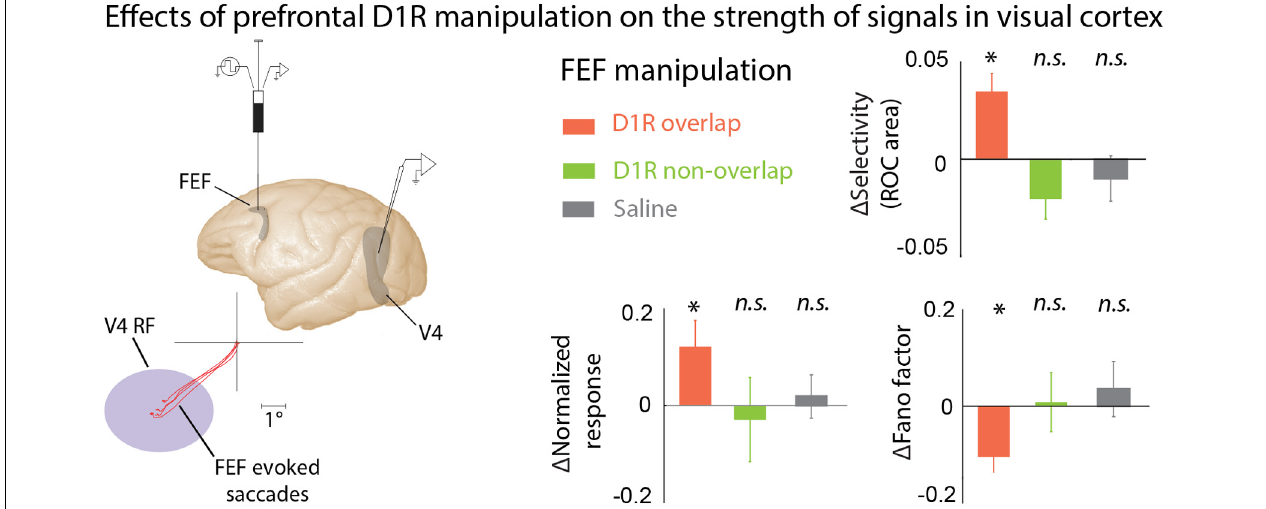
FIGURE 3 | The effects of PFC DA on visual cortical activity. Manipulating D1R-mediated FEF activity enhances visual representations in area V4. Noudoost and Moore (2011b) infused a D1R antagonist into the FEF while recording from V4 neurons with RFs either overlapping or not overlapping the area of space represented at the site of drug infusion; the visual responses of the same V4 neurons were recorded before and after infusion of drugs into the FEF. FEF RF center was